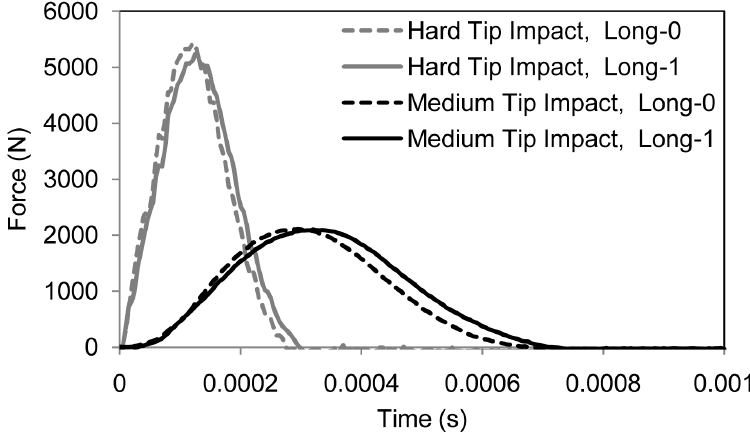
Fig. 9. Applied impact forces on experimental long structures.